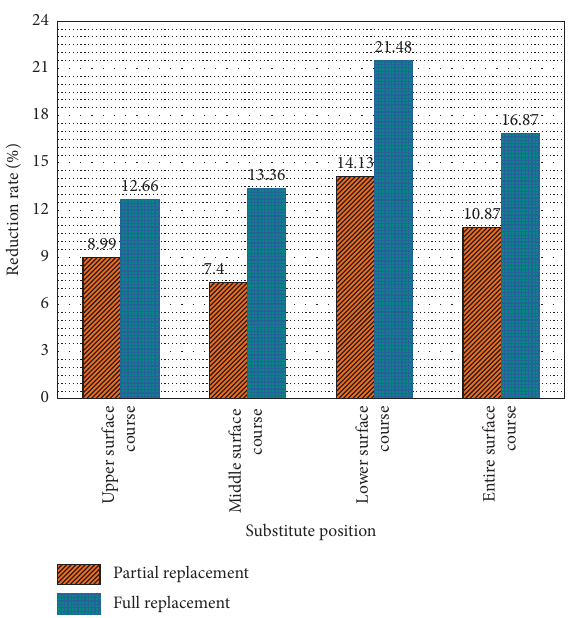
Figure 7: Cost reduction rates of BOF slag as